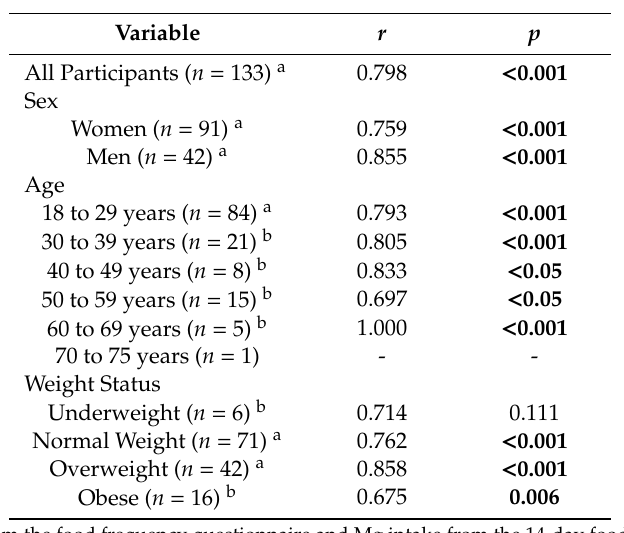
Table 7. Correlations between magnesium food frequency questionnaire and 14-day food diary by sex, age, and body mass